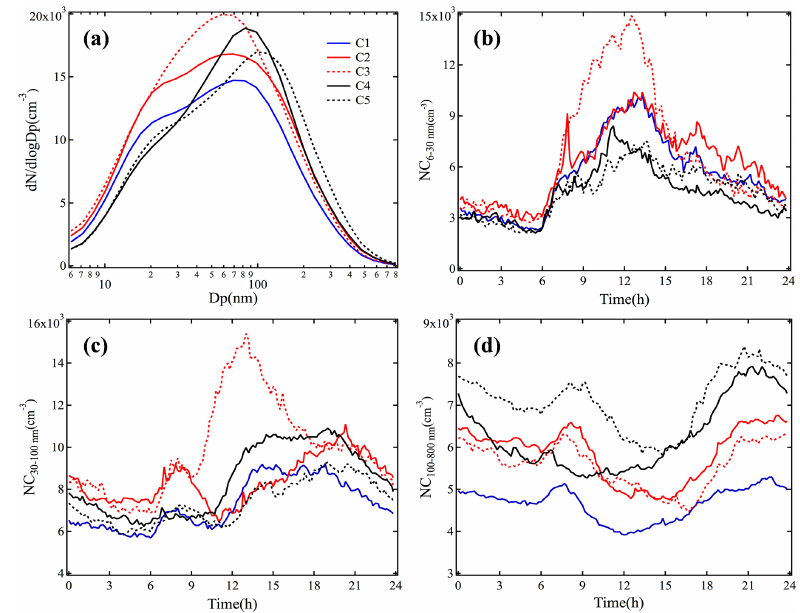
Figure 7. (a) Particle number size distributions of five clusters (C1, C2, C3, C4 and C5 air masses, respectively); diurnal variations of particle number concentration of five clusters in (b) nucleation (6–30nm), (c) Aitken (30–100nm) and (d) accumulation modes (100–800nm). Table 2. Statistics of NPF events, J 6 and GR 6–30nm at the SORPES station during the 2-year measurement period (SD: standard deviation). Spring Summer Autumn Winter Event classification Class I 52